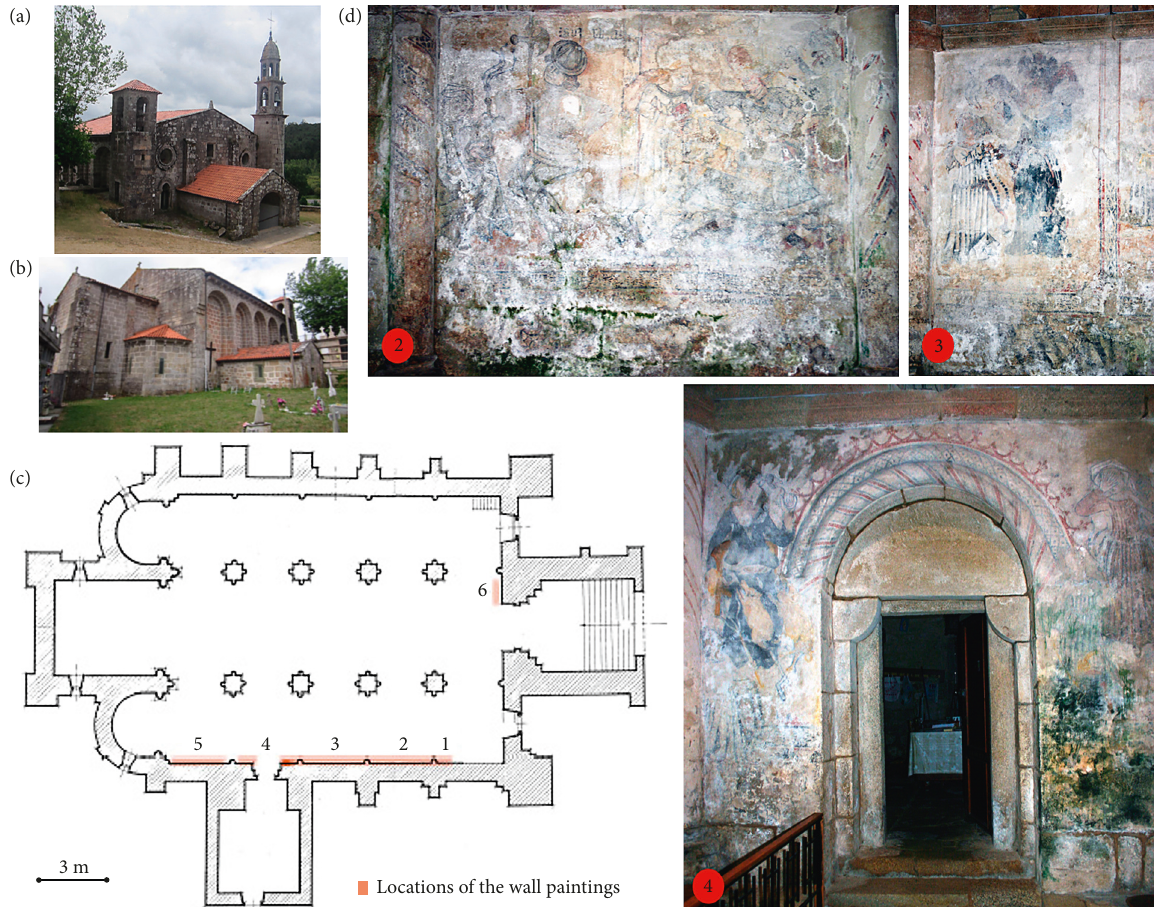
Figure 9: General view of the San Juli´an de Moraime Church (a), northern wall (b), plant view of the interior and locations of the wall paintings (c), and some of the paintings showing deterioration